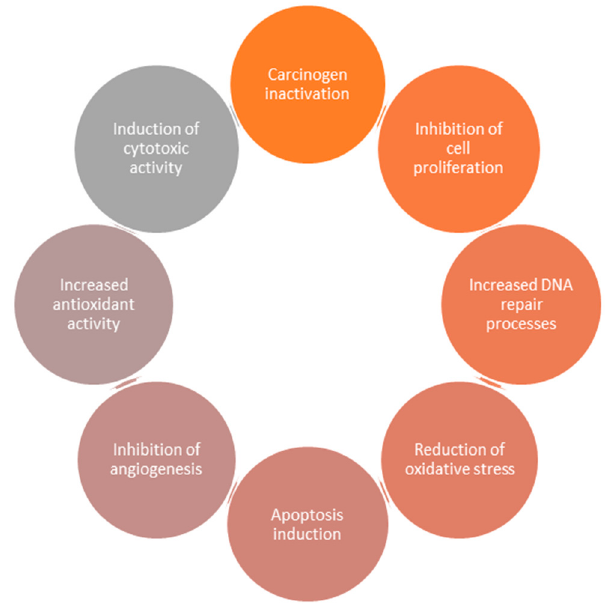
Figure 2. Schematic representation of the main mechanisms responsible for the anticancer potential of flavonoids.